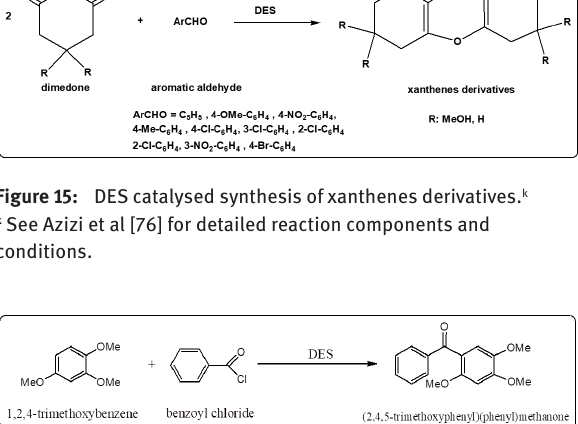
Figure 17: One-pot synthesis of 2H-indizolo[2,1-b]phthalazine- triones catalyzed by ChCl- p TSA. l